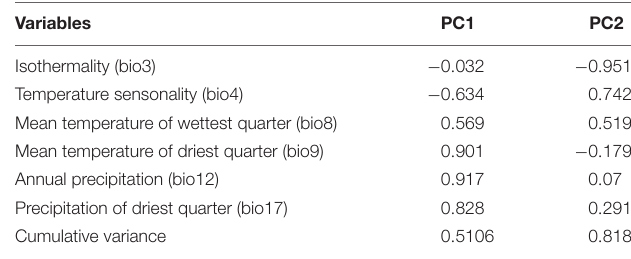
TABLE 4 | Loadings on the first two components for PCA-env